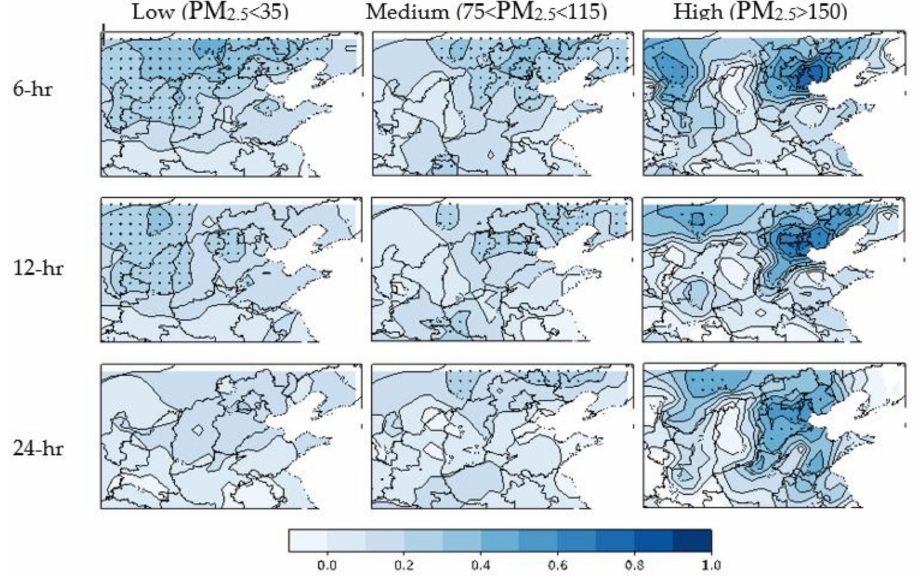
Figure 3. The time-lagged correlation coefficient map between PM 2.5 in Beijing and other areas in North China. The first, second and third columns, respectively, show the spatial distribution of time-lag correlation coefficient of PM 2.5 concentration in Beijing when the daily mean value is low, medium and high. From top to bottom, they show the correlation between Beijing and the surrounding areas in the first 6, 12 and 24 h, respectively. The black dot area indicates that the correlation has passed the 99% significance test, which was calculated by t -test and p